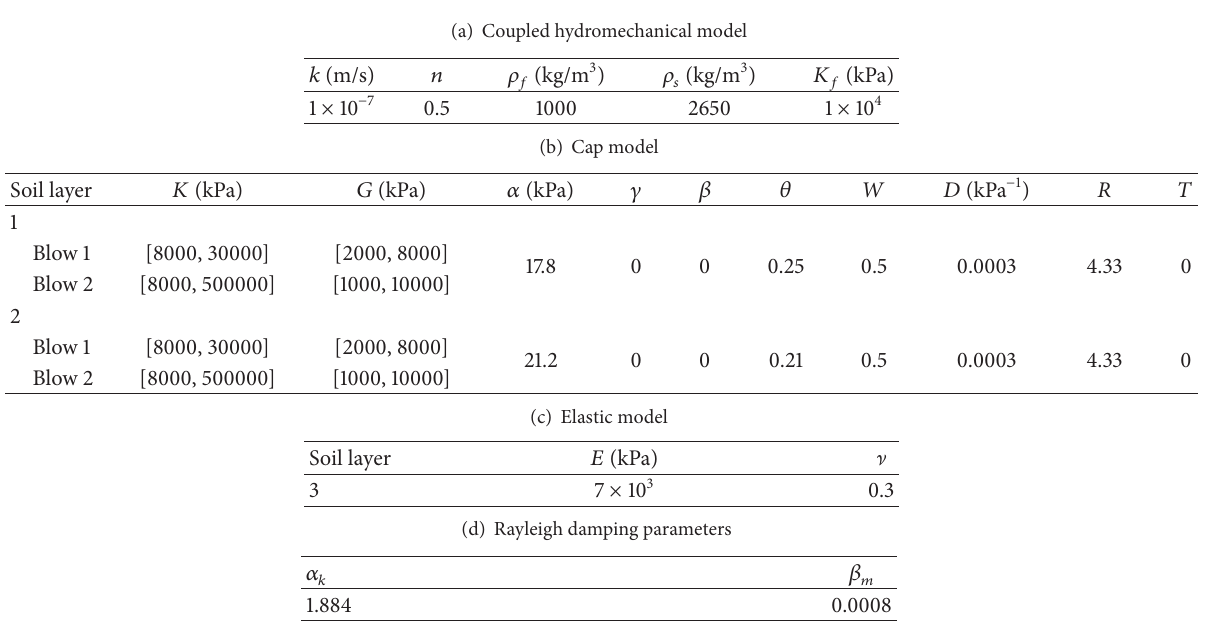
Table 2: Input data for dynamic compaction